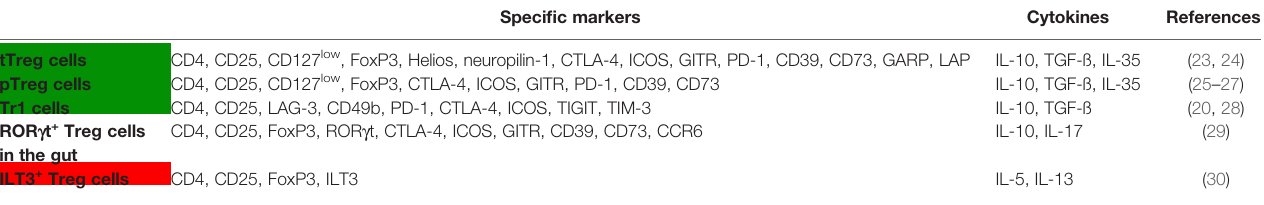
TABLE 1 | Treg cell subsets involved in allergic in fl ammation and increased (green) or decreased (red) during AIT or